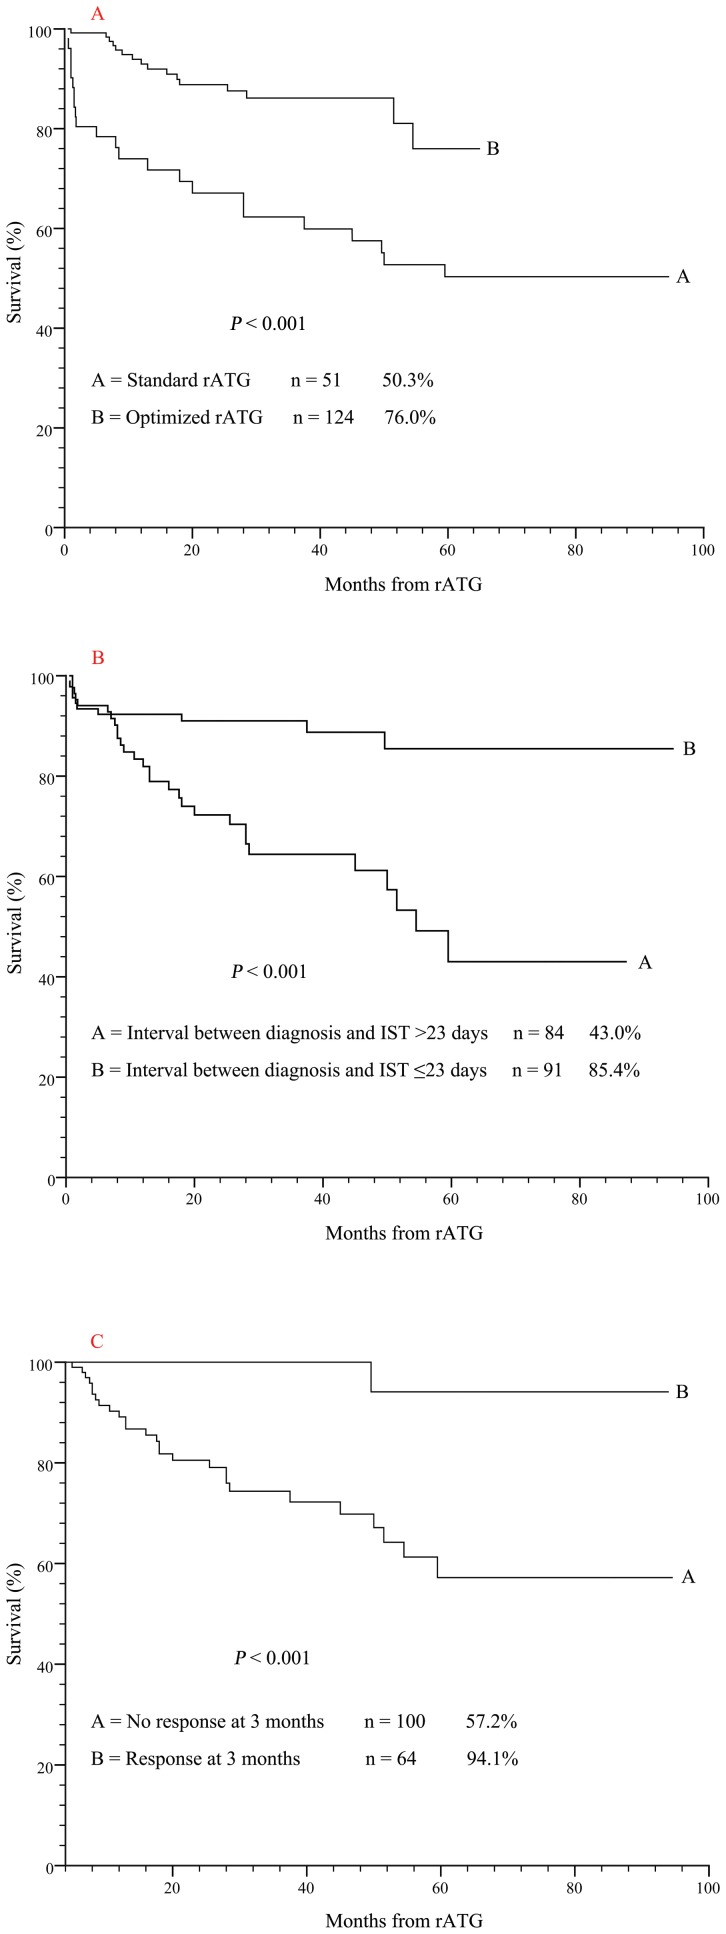
Kaplan-Meier curve of overall survival.A, The 5-year OS of patients received Optimized rATG was superior to that of patients received Standard rATG (P<.001). B, Longer interval between diagnosis and IST (>23 days) predicted a worse 5-year OS (P<.001). C, The patients with response at 3 months had significantly higher 5-year OS (P<.001).